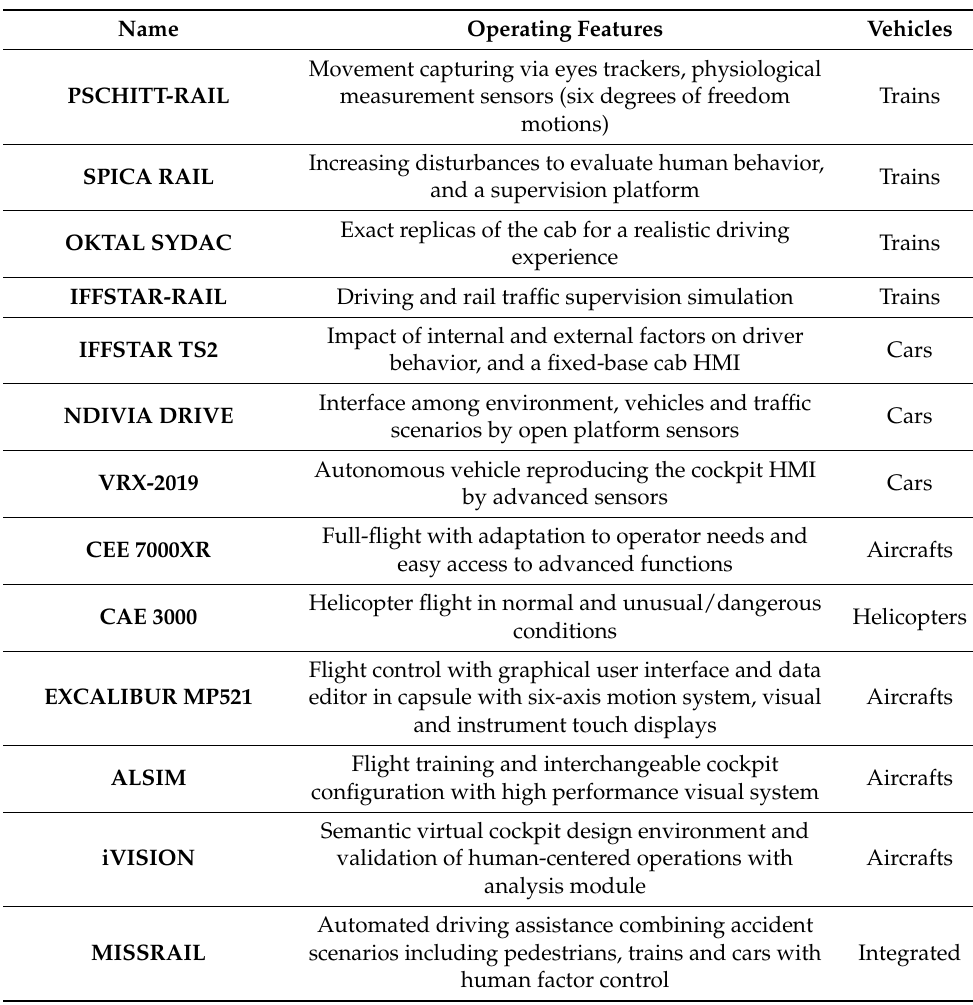
Table 3. Overview of investigated